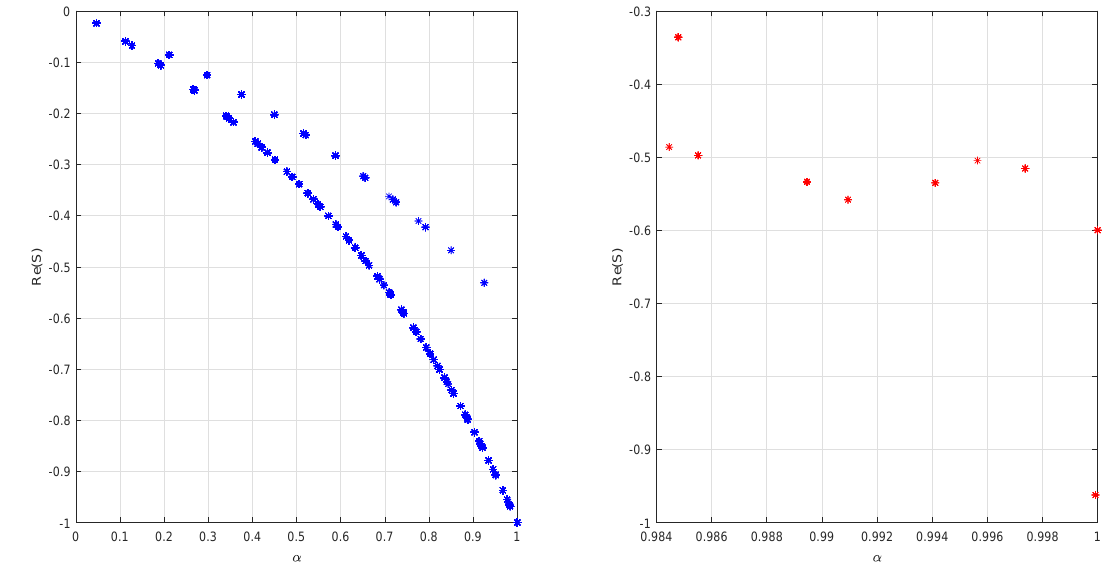
Figure 1. Relations between Re(s) and α (left is det ( ∆ ( s )) = 0, right is Equation (7)). Theorem 1. If ( I − ( 1 − α ) A ) is invertible, then system (3) is asymptotically stable if and only if the real parts of the roots to the character equation of the system (3) are